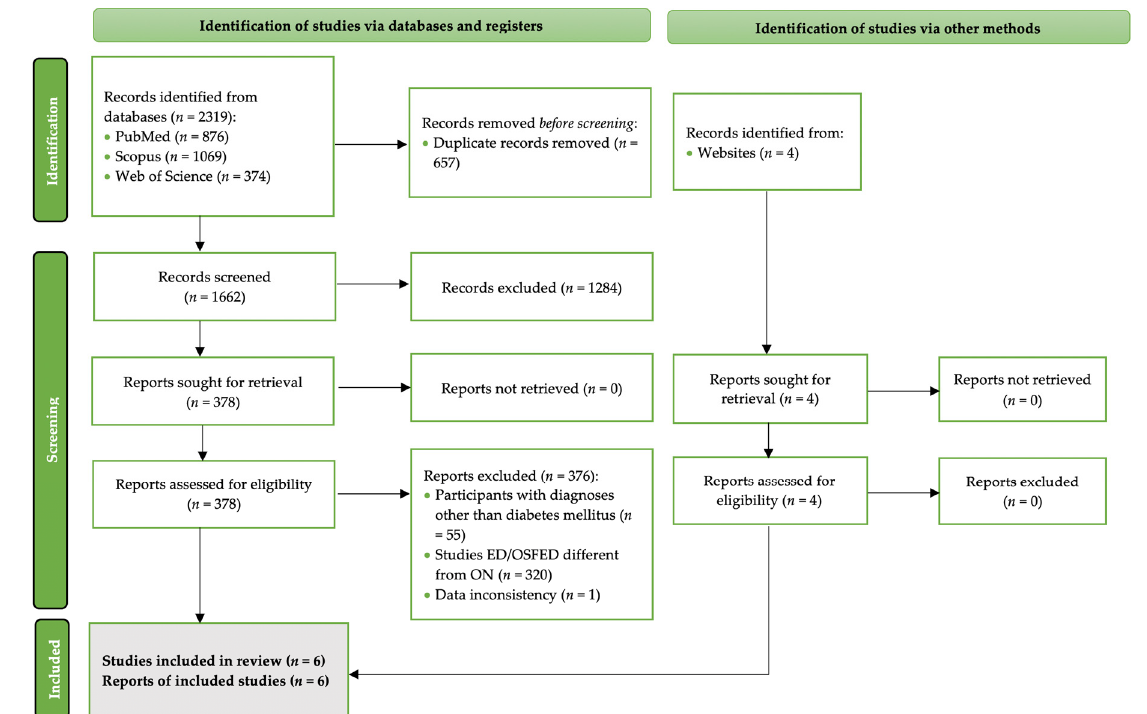
Figure 2. The PRISMA 2020 flowchart of the study selection process [33].